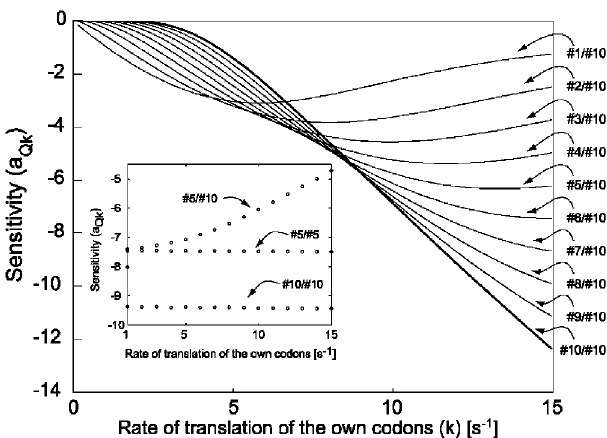
Figure 5. The Sensitivity Amplification a Qk Is Plotted as a Function of the Rate of Translation of Regulatory Codons The different curves correspond to different number of regulatory codons in a control region that has in total ten codons. # i /# j indicates i regulatory codons out of j codons in the control region. The rate of translation for non-regulatory codons is 15 s (cid:1) 1 . The RNAP transcribes 50 nt s (cid:1) 1 ( q ¼ 50 s (cid:1) 1 ) and the total number of RNAP steps is 80 ( n ¼ 80). Insert : The sensitivity amplification a Qk is plotted as in the main figure, but now the rate of transcription (q) is scaled such that Q ¼ 0.01 for each point. DOI: